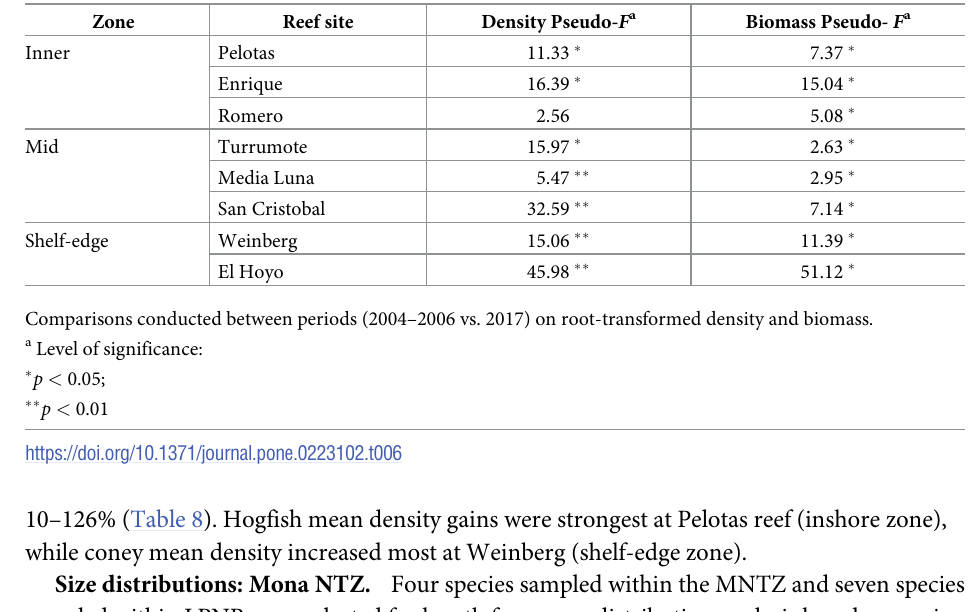
Table 6. Summary of pairwise PERMANOVA by reef site in the LPNR.